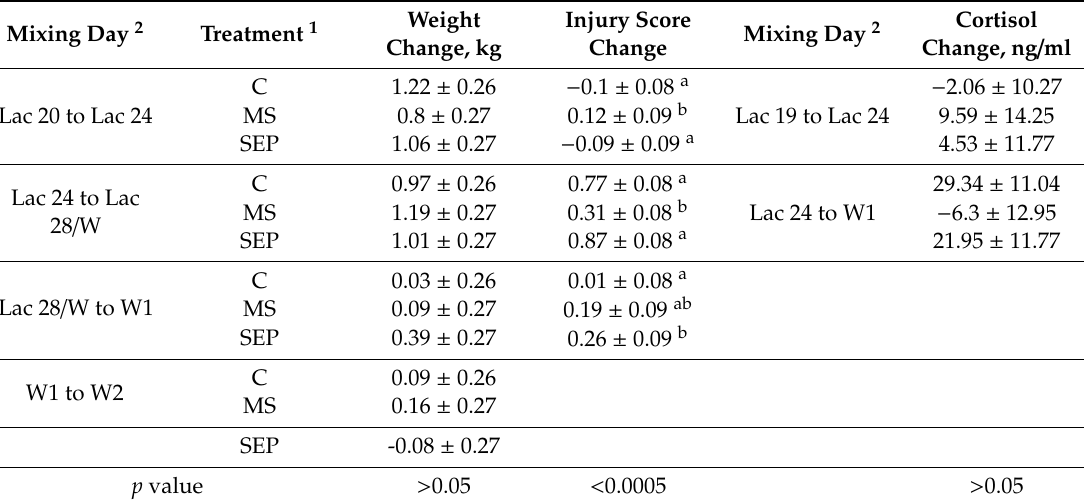
Table 7. The change in piglet condition and stress and the e ff ect of treatment by